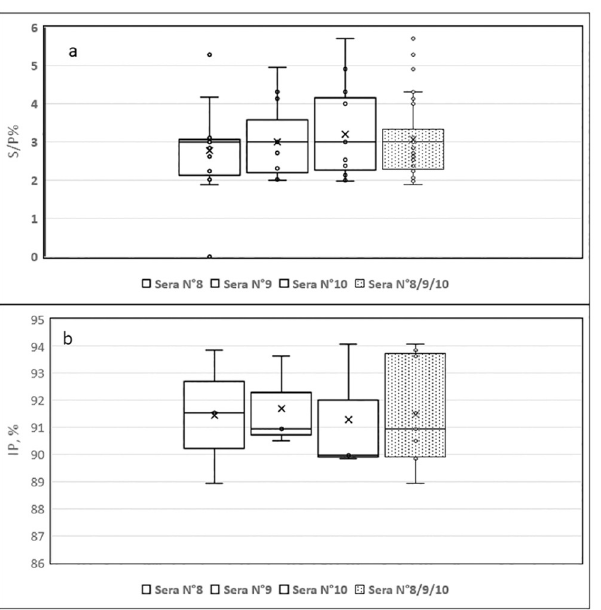
Fig 4. Assessment of the inter-repeatability based on the 3 sera included in the panel specifically for that purpose. Distribution of the Competitition Percentage (CP, %) or Inhibition Percentage (IP, %), depending on the test used, either ID Screen 1 Rift Valley Fever Competition Multi-species (a) or INgezim FVR Compac (b). White boxes correspond to inter-repeatability for each of the 3 sera whereas the dotted box corresponds to the global inter-